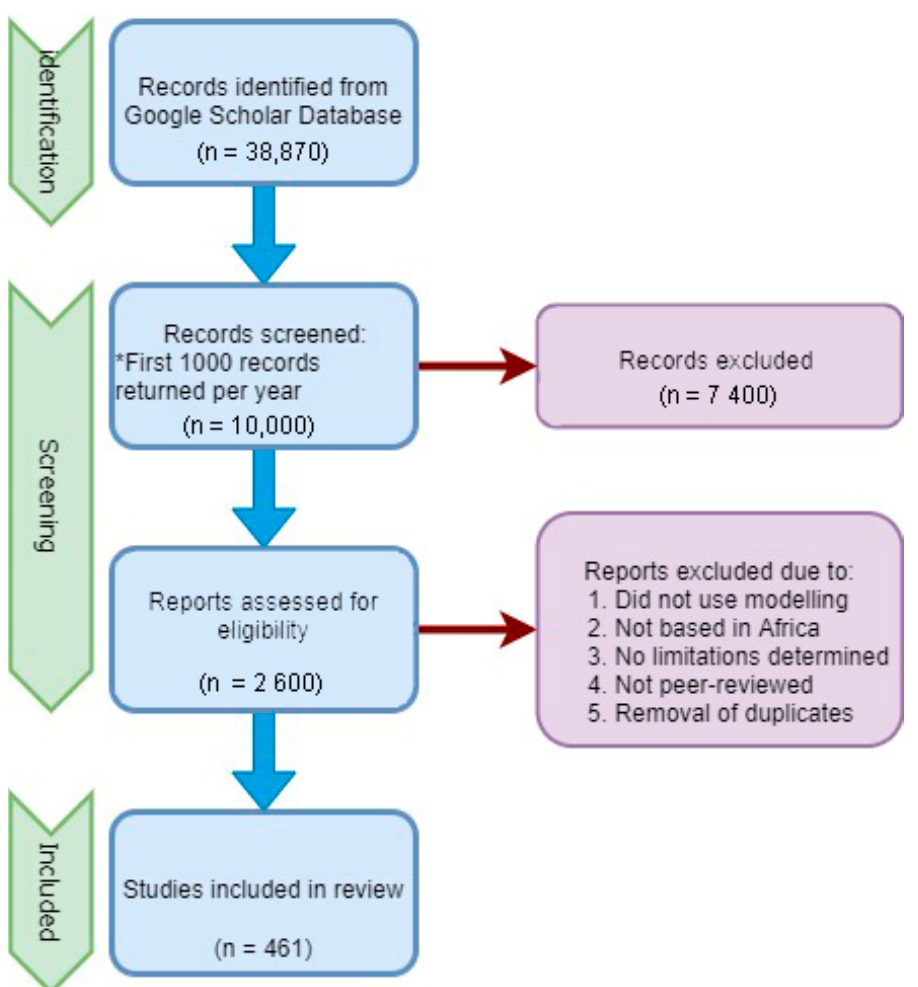
Figure 1. PRISMA chart for articles reviewed from the Google Scholar Database.